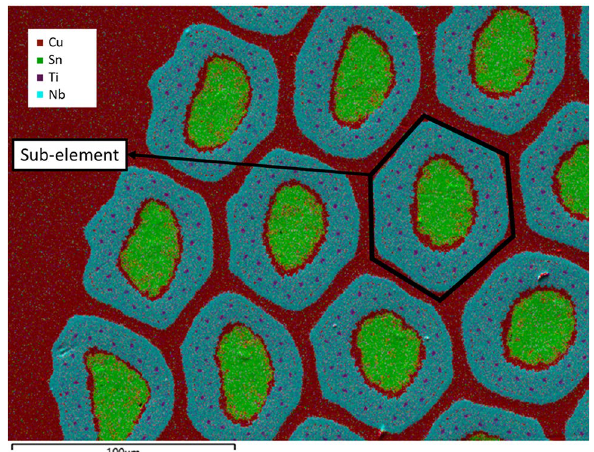
Figure 10. Cross section of S21 Nb 3 Sn RRP wire before heat treatment. The picture is a combination of a Scanning Electric Microscope (SEM) image and an Energy-dispersive X-ray spectroscopy (EDX) analysis of the surface. The sub-elements are surrounded by high purity Cu matrix. Each sub-element is an assembly of Nb and Nb-Ti filaments in a Cu matrix built around a Sn rod. The Nb barrier, around the sub-element, prevents Sn diffusion in the Cu matrix during the heat